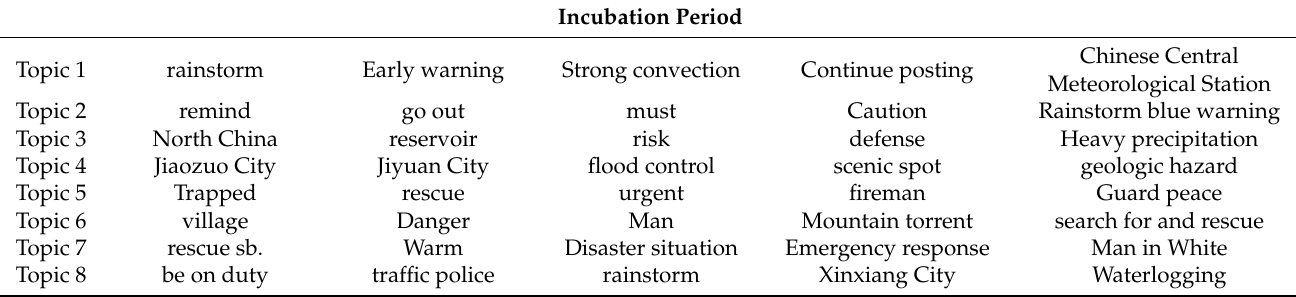
Table 1. Text topic extraction results in the incubation period.